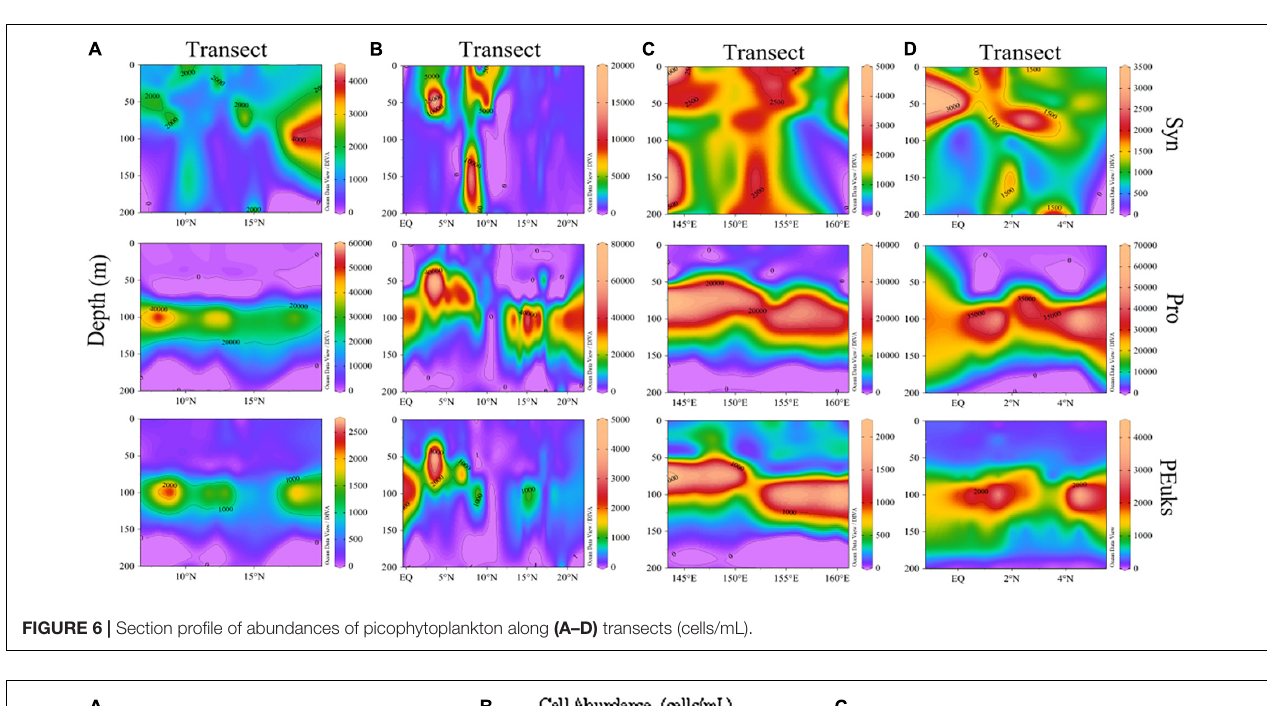
FIGURE 5 | Spatial distributions of surface abundance of (A) Synechococcus ; (B) Prochlorococcus ; (C) Picoeucaryote (cells/mL).